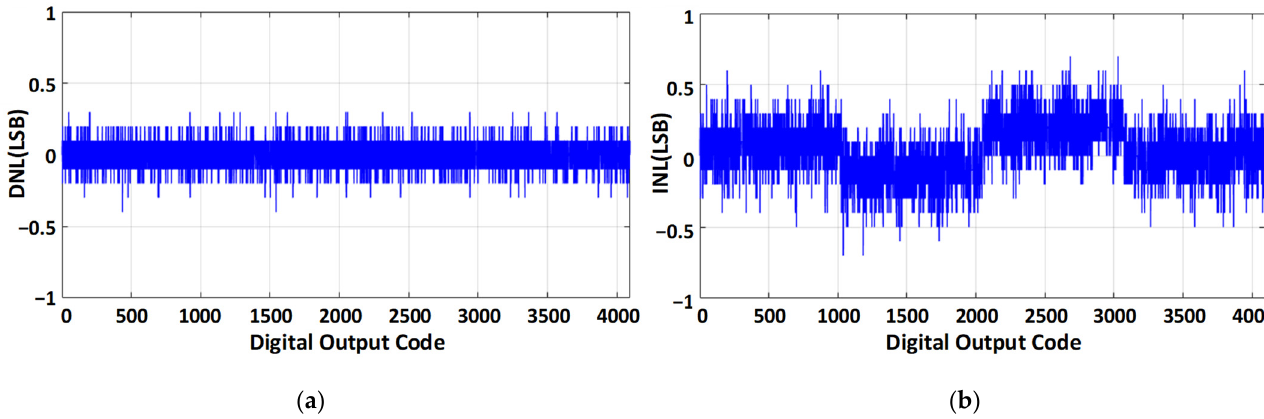
Figure 7. Static performance with behavioral model of proposed switching technique with 1% unit capacitor mismatch ( a ) differential non-linearity (DNL), and ( b ) integral non-linearity (INL).